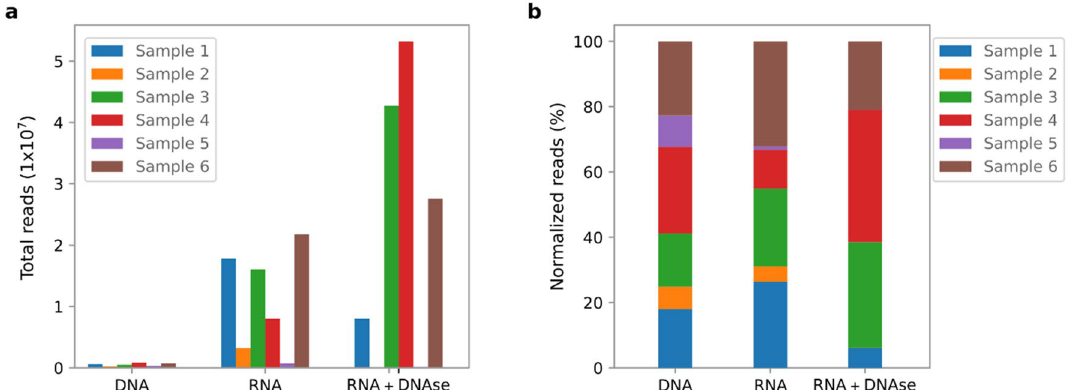
Figure 1. The number of bacterial reads in the 6 cervical swab samples by the 3 sequencing approaches (DNA sequencing, RNA sequencing and RNA sequencing with prior DNase-treatment) ( a ) and the distribution of the reads among the 6 samples normalized for each of the 3 sequencing approaches ( b ). (Image created using Python v. 3.8.5 and Seaborn library v. 0.10.1, https:// seabo rn. pydata. org/ and Inkscape v. 1.1, https:// inksc ape.